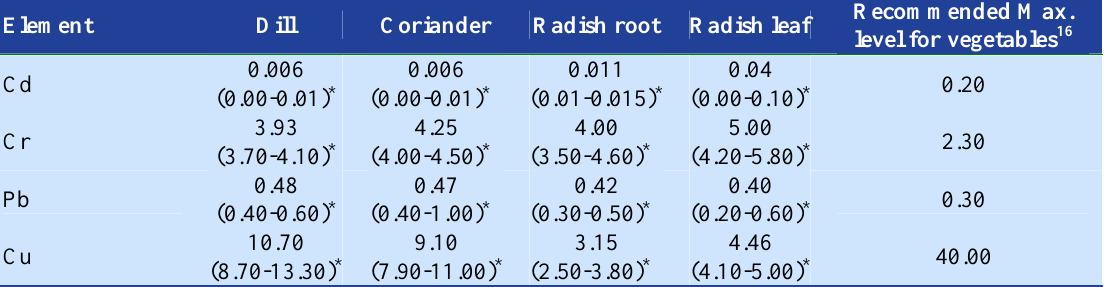
Table 4. Concentration of heavy metals in vegetables cultivated in main farmland areas of Sanandaj, Iran, in terms of mg Kg -1 dry weight